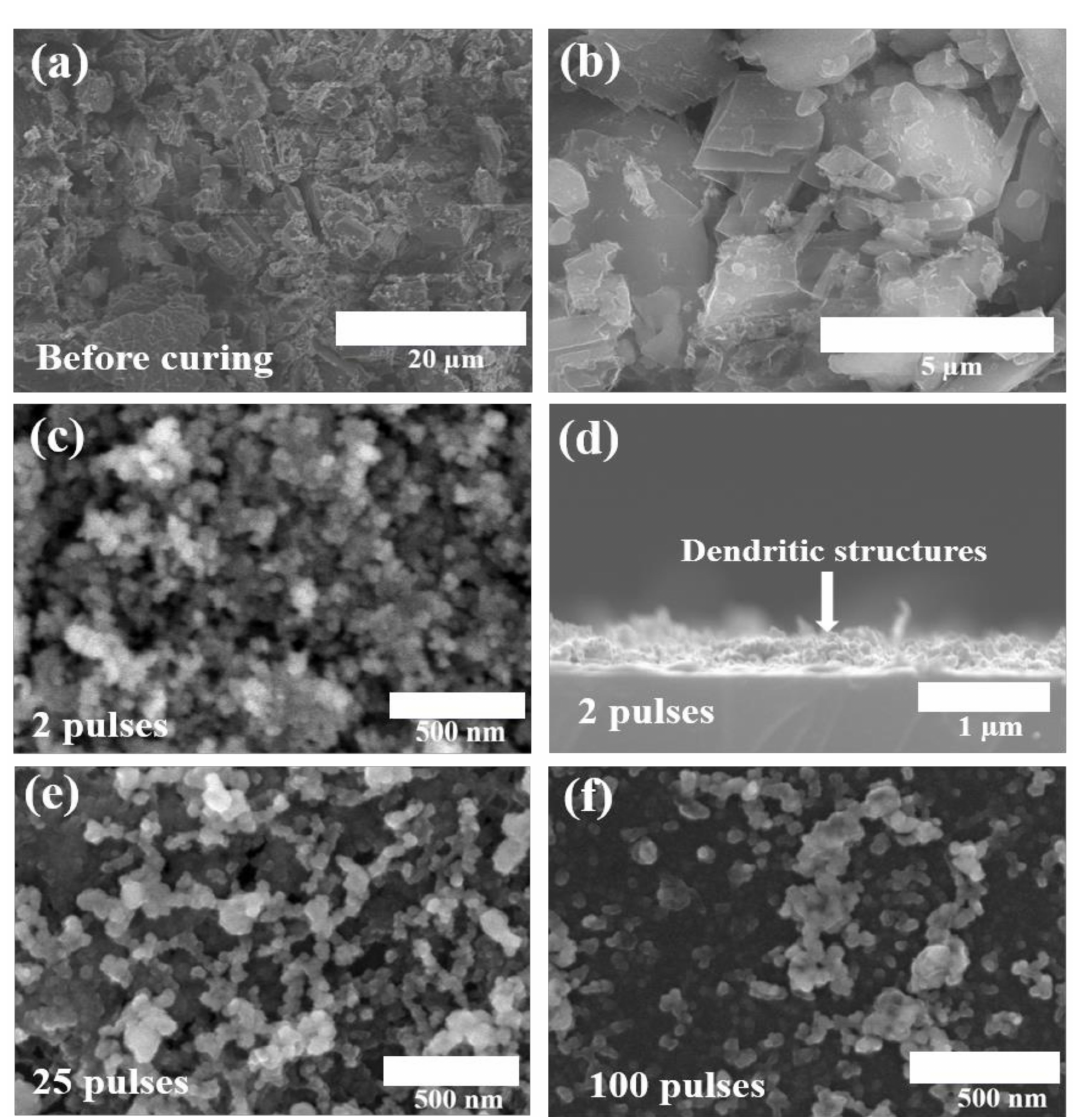
Figure 3. SEM images of precursor thin film sample before curing ( a , b ). SEM surface and cross-sectional morphology, respectively, of 2 pulses cured electrode ( c , d ), and surface morphology of 25 and 100 pulses cured electrodes ( e , f